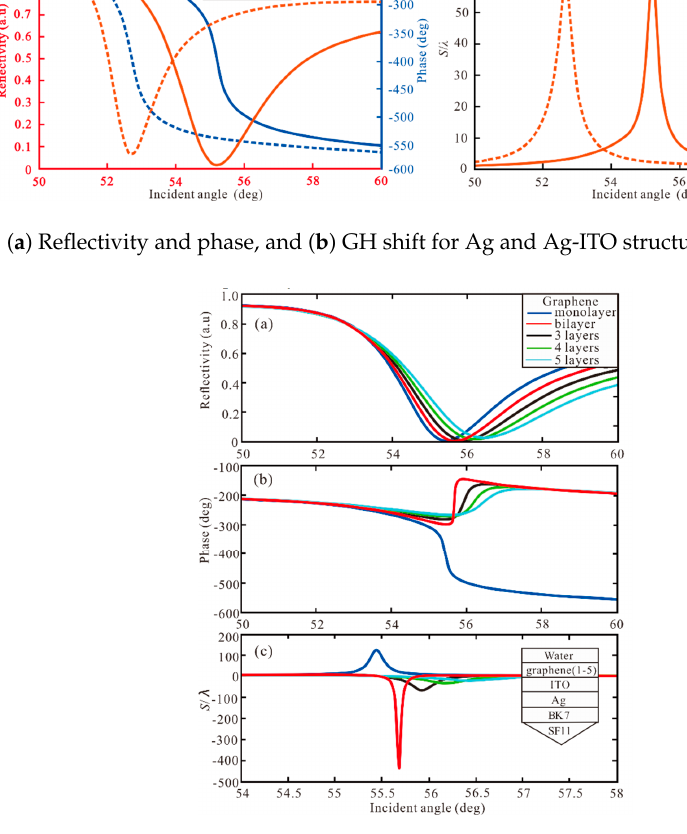
Figure 3. ( a ) Reflectivity, ( b ) Phase and ( c ) GH shift with incident angle for different number of graphene layers. Similarly, the BlueP/TMDCs is added to the Ag-ITO structure, as shown in Figure 4. In Table 2, the optimal GH shift (S/ λ ) with different number of BlueP/TMDCs is obtained. Hence, In the BlueP/TMDCs, we can understand that the BlueP/MoSe 2 has the greatest contribution to Ag-ITO structure. Table 2. The optimal GH shift (S / λ ) with di ff erent number of BlueP / TMDCs. BlueP /